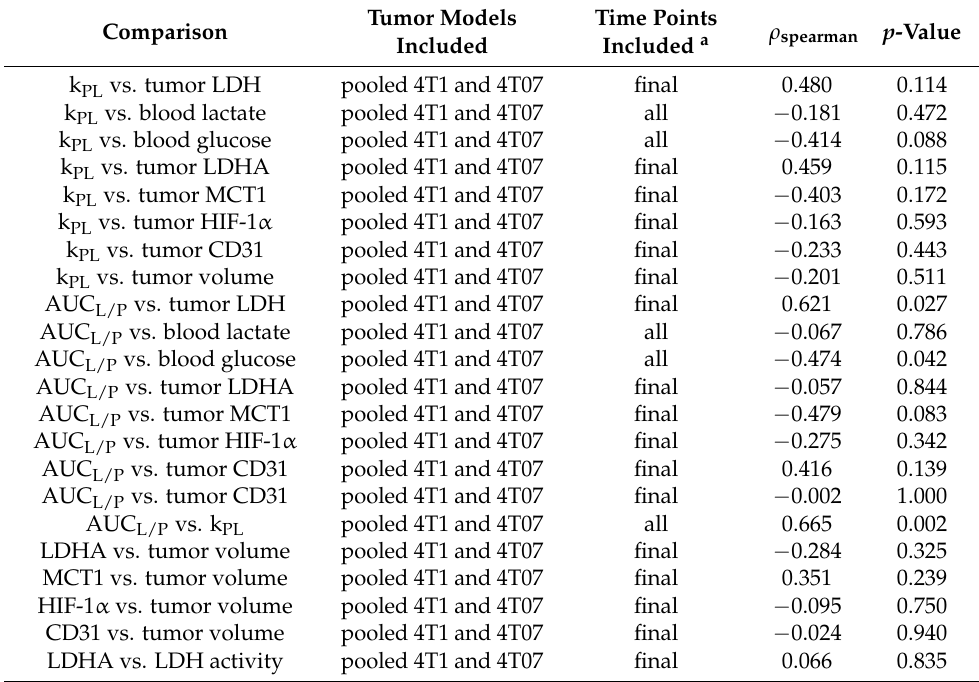
Table 3. Spearman correlation results.